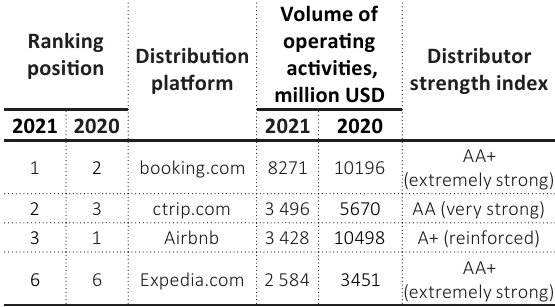
Table 2. Ranking positions of hospitality distribution